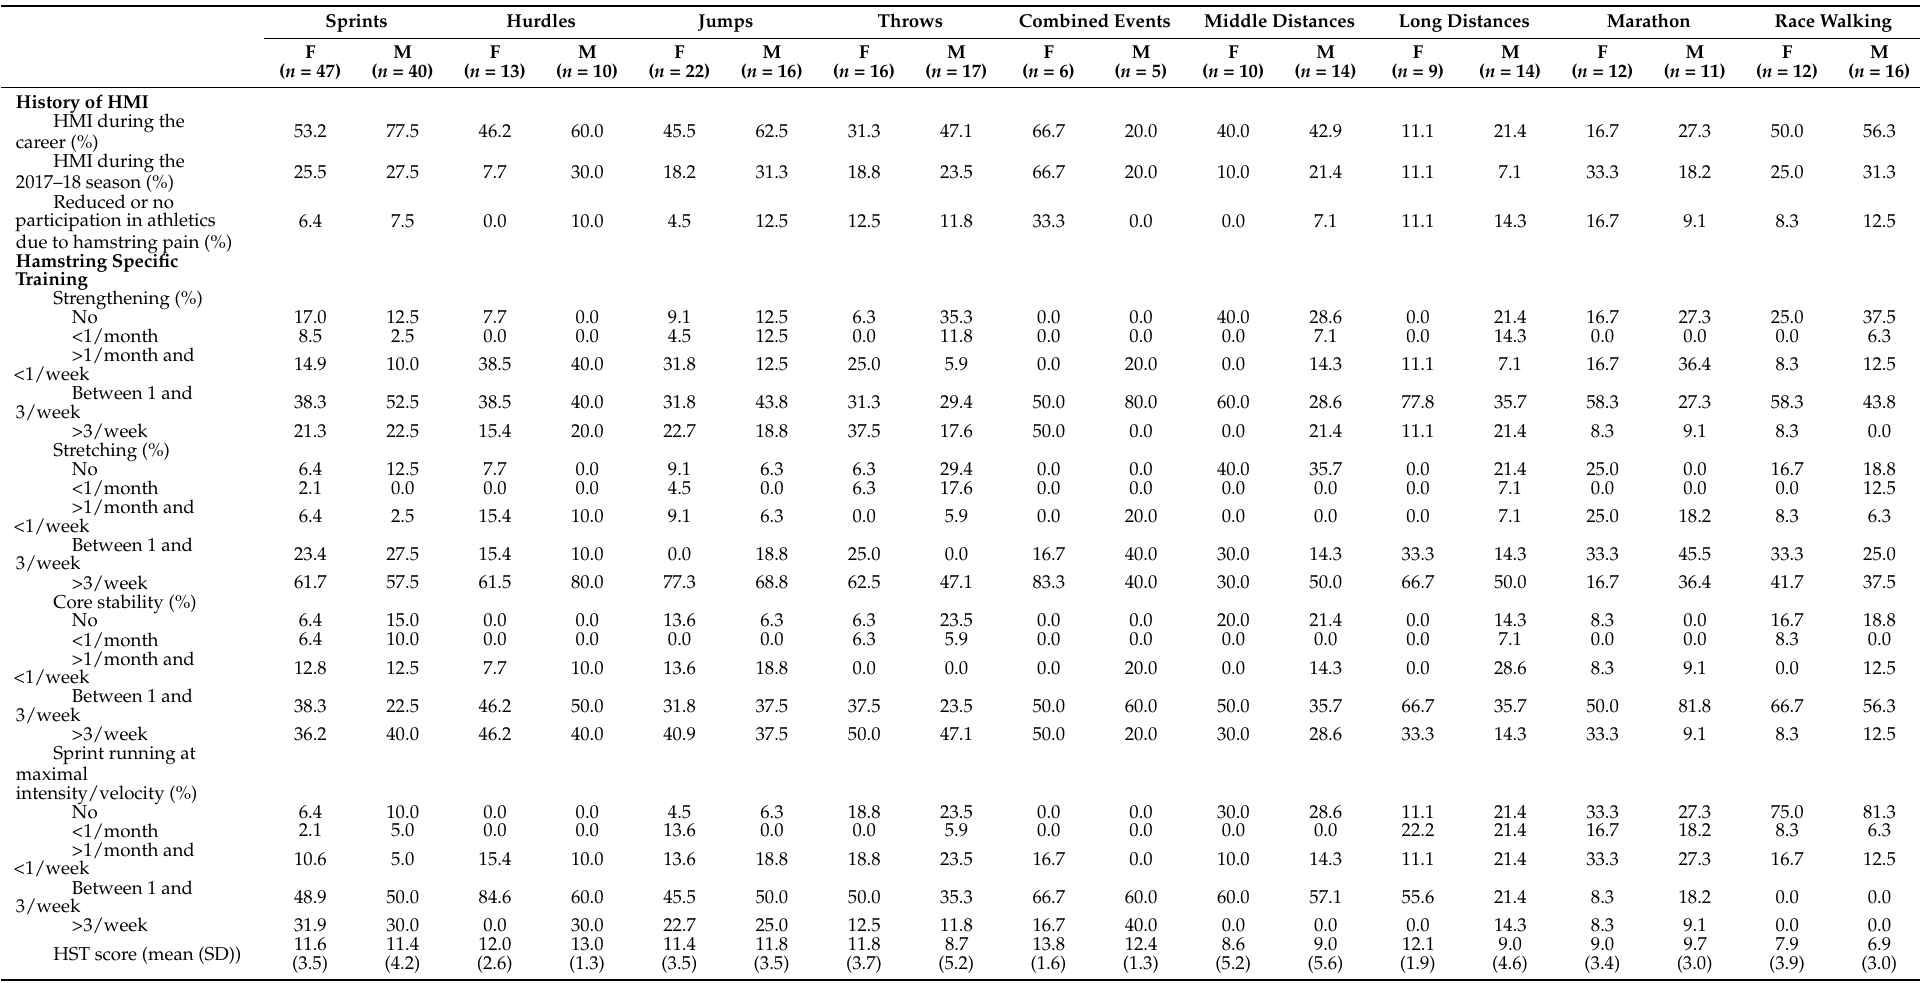
Table 2. History of hamstring muscle injuries (HMI) and hamstring specific training (HST) among the included athletes who participated at the 24th European Athletics Championships in Berlin in 2018 ( n = 290) according to discipline and sex. Sprints